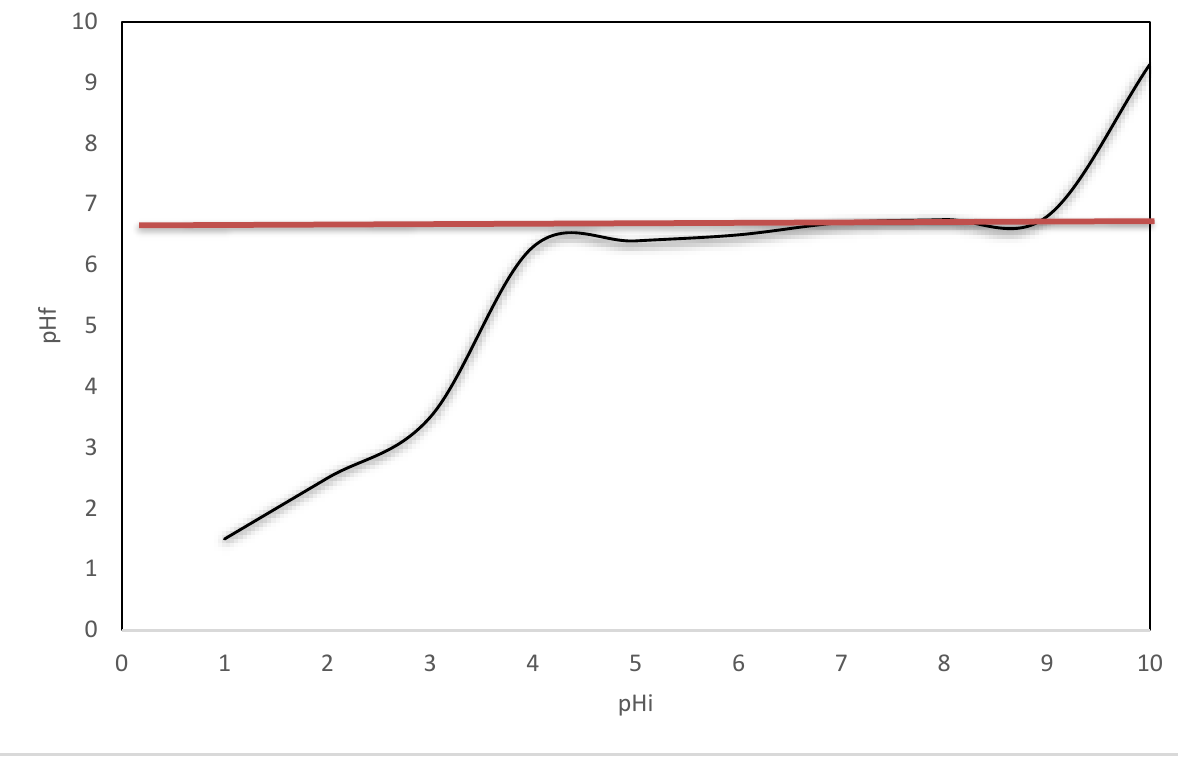
Figure 1. pHpzc experimental determination.